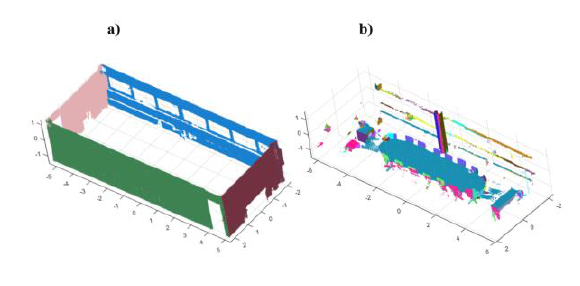
Figure 6: Regions classified as walls (a) and regions classified as obstacles